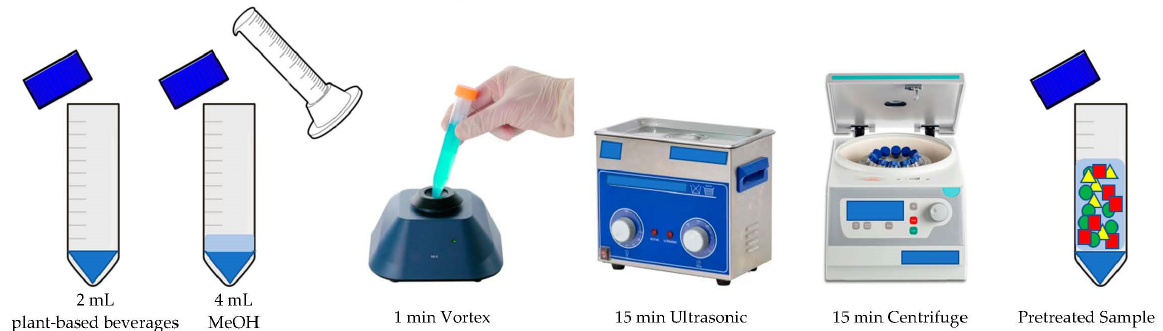
Figure 1. Drawing of sample pretreatment